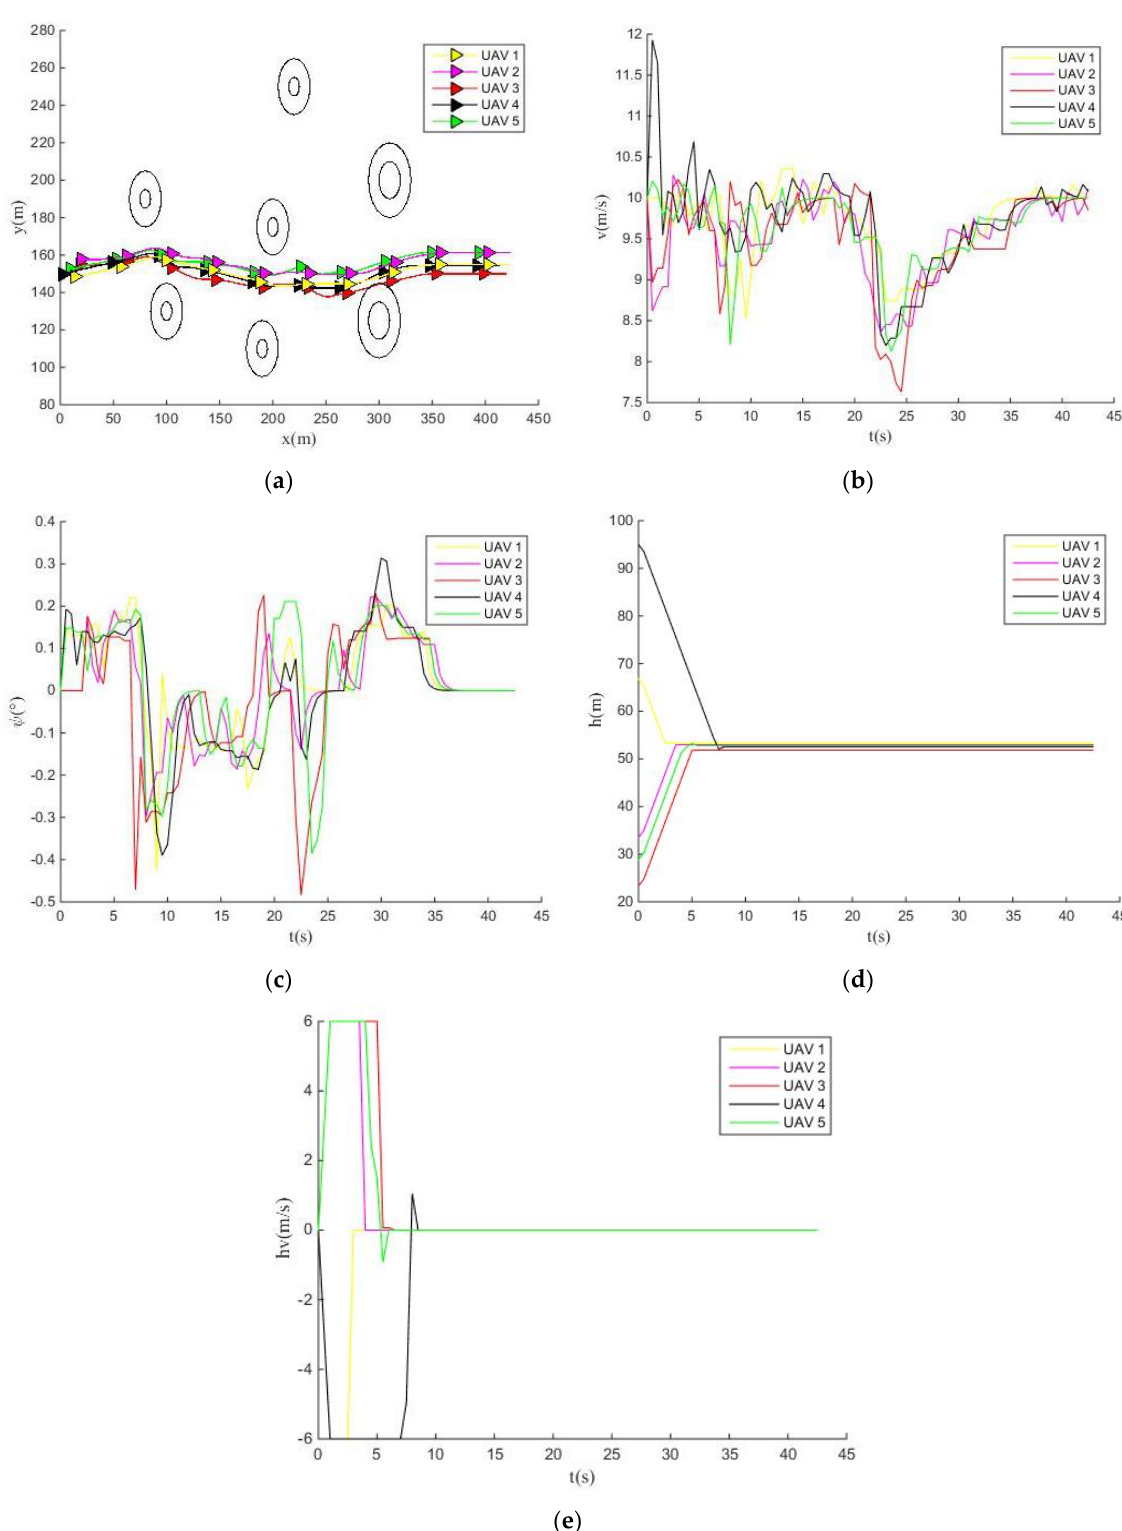
Figure 14. MOCS optimizes the flight change curves of UAVs. ( a ) Obstacle avoidance curve of UAVs; ( b ) Horizontal airspeed change curves of UAVs; ( c ) Yaw angle change curves of UAVs; ( d ) Flight altitude change curves of UAVs; ( e ) Altitude rate change curves of UAVs.